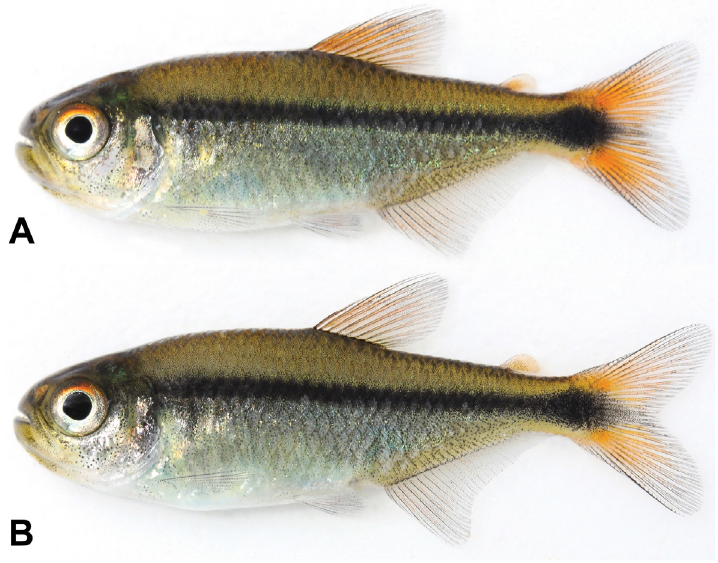
FIGURE 3 | Live coloration of Astyanax nobre , paratypes, MZUSP 118302: A. Male; B. Female. Specimens not measured. Photo by W. Ohara.